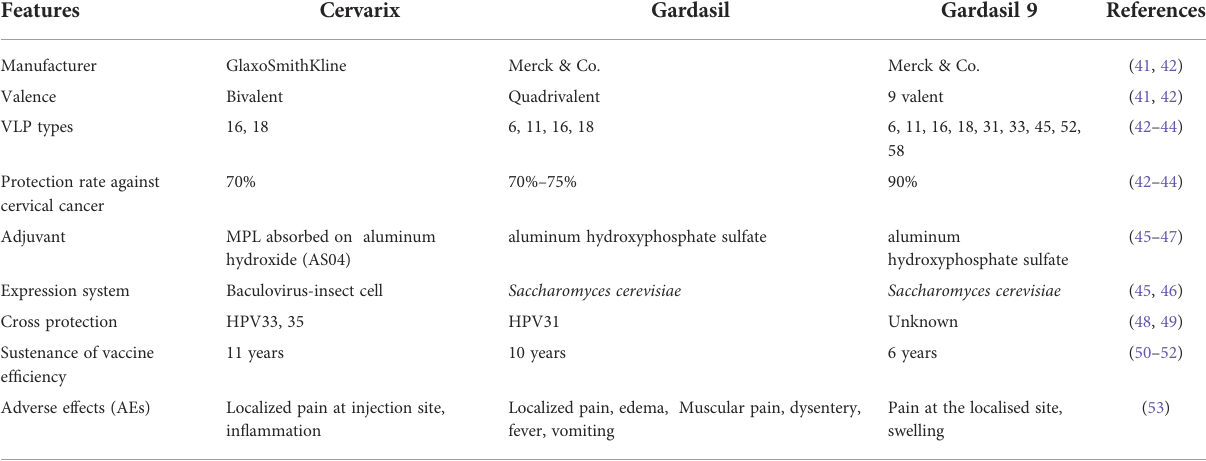
TABLE 1 Comparative analysis of Cervarix and Gardasil vaccine against HPV infection.